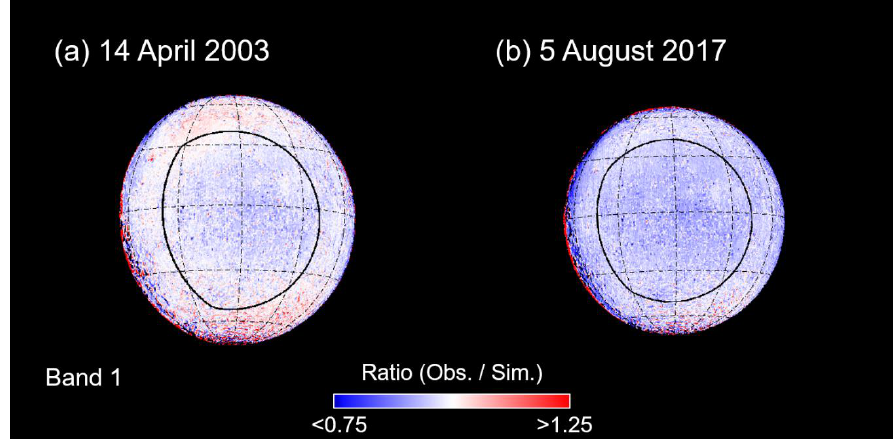
Figure 5. Brightness ratios for the observed and simulated brightness of the Moon for Band 1 in ( a ) 2003 and ( b ) 2017. The regions surrounded by solid black lines (incident angle < 60°, emission angle < 45°) were used for evaluating the sensitivity degradation.